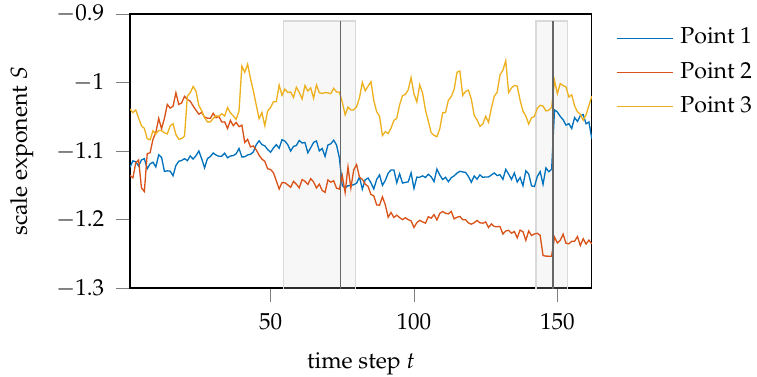
Figure 11. Temporal development of scale exponent values during the shear-cutting